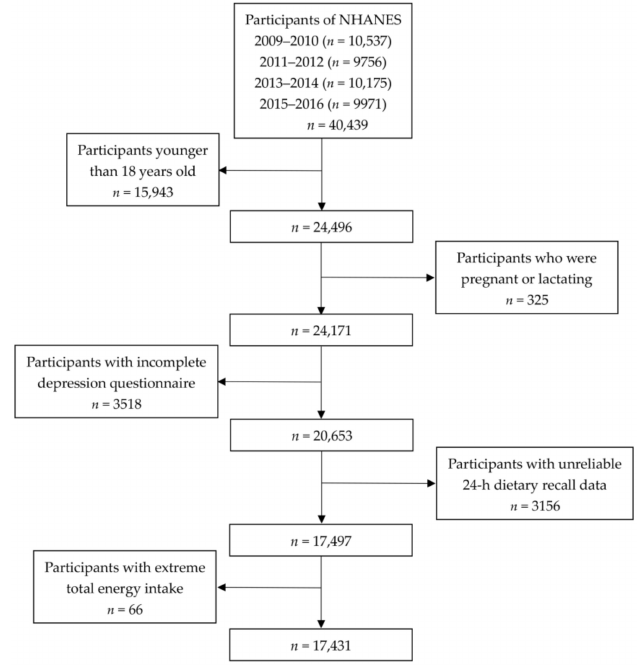
Figure 1. Flow chart of the screening process for the selection of eligible